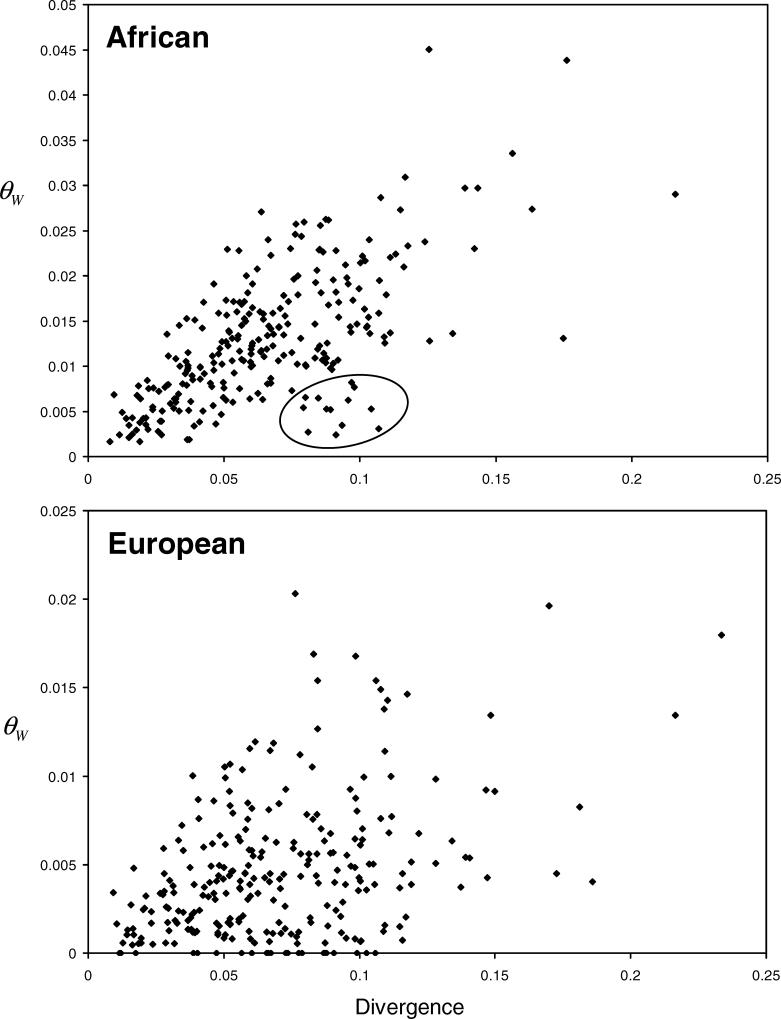
Watterson's θW versus Divergence between D. melanogaster and D. simulans
Pearson's r = 0.65, p < 0.01 in the African sample; Pearson's r = 0.40, p < 0.01 in the European sample. In the African sample, 13 loci are circled because of their high divergence and low θW.